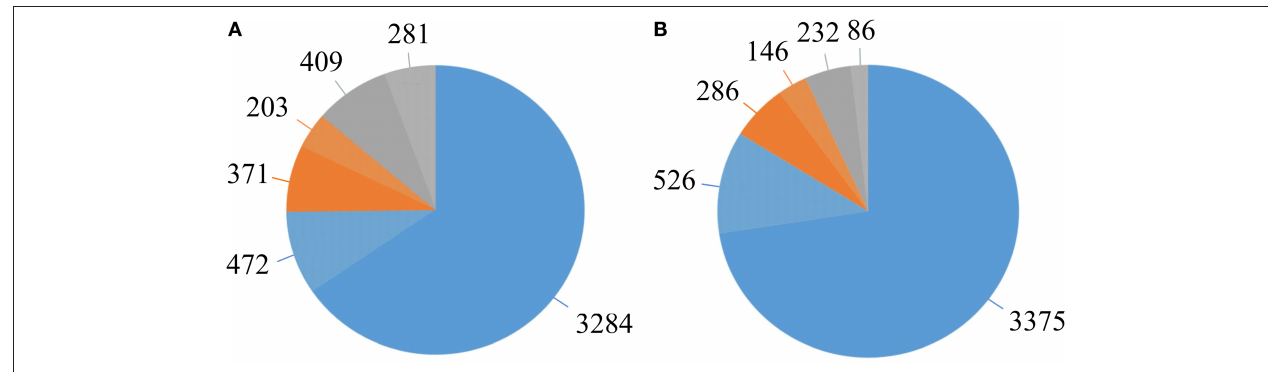
FIGURE 5 | The D. solani pangenome shape. (A) Pangenome shape based on the number of genes in all 14 strains. (B) Pangenome shape after exclusion of strain RNS 05.1.2A. Blue—represents the core genome. Orange—represents the accessory genome. Gray—represents the unique genome. Lighter shades of each color represent the fractions of genes annotated as hypothetical